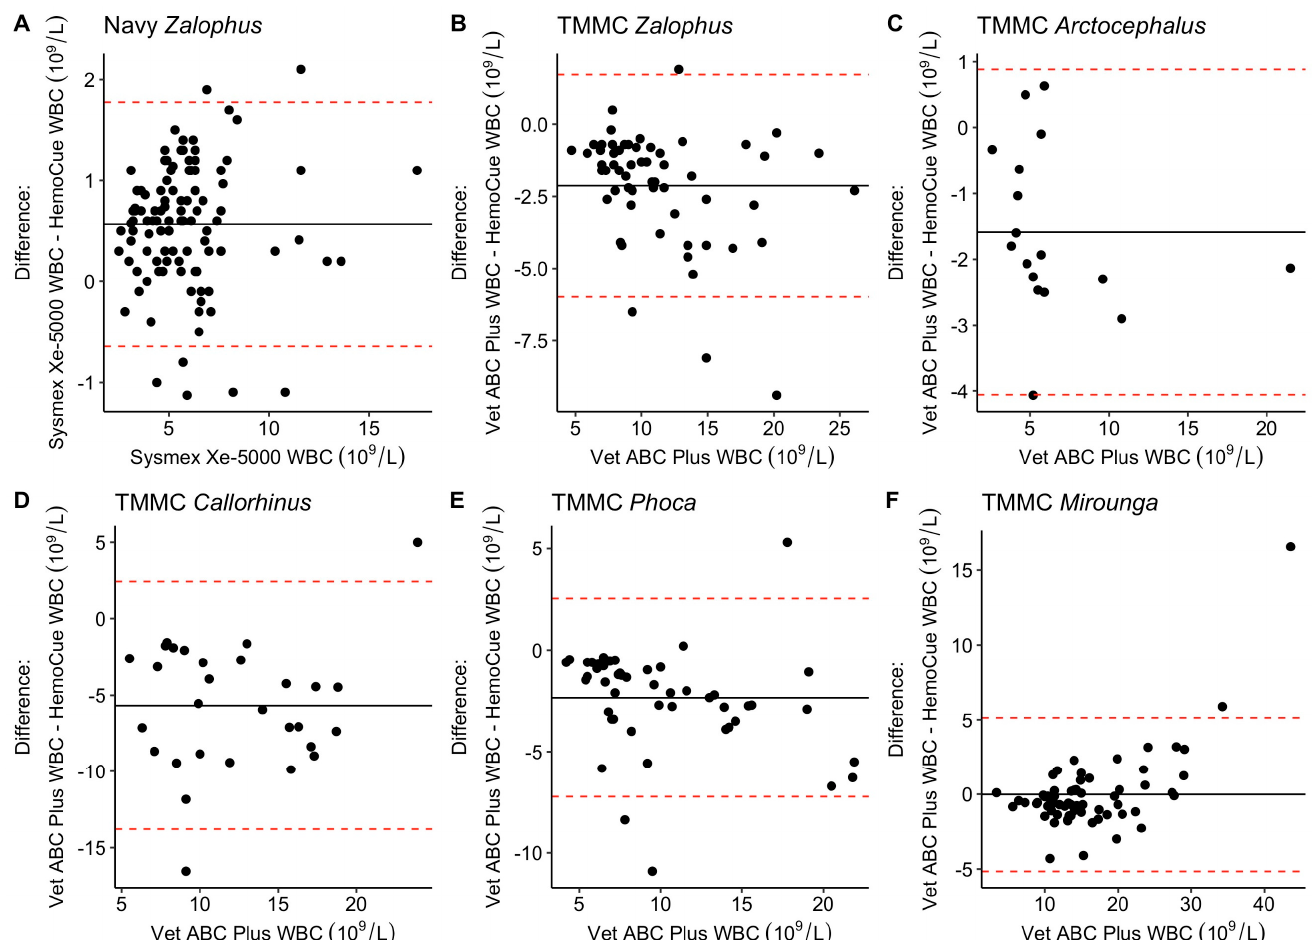
Figure 1. Bland-Altman plots comparing the corrected WBC counts between the comparative an- alyzers and the HemoCue ® WBC system for each species. ( A ) Bland-Altman plot of U.S. Navy Marine Mammal Program California sea lion ( Zalophus californianus ) samples comparing the Sysmex Xe-5000 automated hematology analyzer to the HemoCue ® WBC system. The Sysmex Xe-5000 WBC count is depicted on the x-axis. The difference between the Sysmex Xe-5000 WBC count and the HemoCue ® WBC system WBC count is depicted on the y-axis. The solid black line indicates the overall bias, and the red dashed lines indicate the upper and lower limits of agreement. ( B ) Bland- Altman plot of The Marine Mammal Center (TMMC) Zalophus samples comparing the Vet ABC Plus automated hematology analyzer to the HemoCue ® WBC system. The Vet ABC Plus WBC count is depicted on the x-axis. The difference between the Vet ABC Plus WBC count and the HemoCue ® WBC system WBC count is depicted on the y-axis. ( C ) Bland-Altman plot of TMMC Guadalupe fur seal ( Arctocephalus townsendi ) samples comparing the Vet ABC Plus automated hematology analyzer to the HemoCue ® WBC system. ( D ) Bland-Altman plot of TMMC Northern fur seal ( Callorhinus ursinus ) samples comparing the Vet ABC Plus automated hematology analyzer to the HemoCue ® WBC system. ( E ) Bland-Altman plot of TMMC Harbor seal ( Phoca vitulina ) samples comparing the Vet ABC Plus automated hematology analyzer to the HemoCue ® WBC system. ( F ) Bland-Altman plot of TMMC Northern elephant seal ( Mirounga angustirostris ) samples comparing the Vet ABC Plus automated hematology analyzer to the HemoCue ® WBC